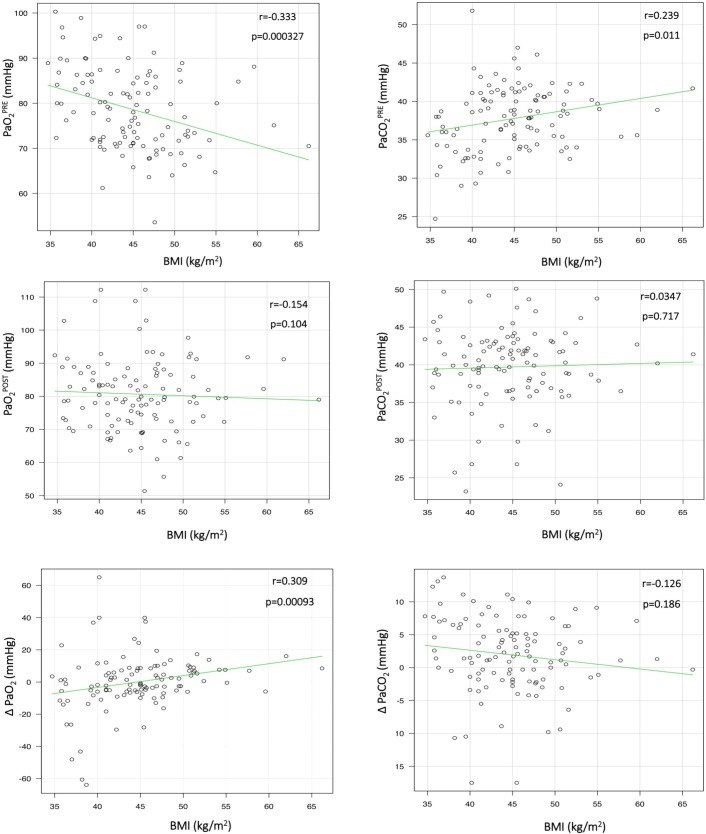
Correlation between body mass index and other variables.As shown, BMI was positively correlated with PaCO2PRE, PaCO2POST, and ΔPaO2 and negatively correlated with PaO2PRE, PaO2POST, and ΔPaCO2. BMI, body mass index; PaCO2POST, postoperative arterial partial pressure of carbon dioxide (PaCO2); PaCO2PRE, preoperative PaCO2; ΔPaCO2, PaCO2POST minus PaCO2PRE; PaO2POST, postoperative arterial partial pressure of oxygen (PaO2); PaO2PRE, preoperative PaO2; ΔPaO2, PaO2POST minus PaO2PRE; r, Bravais-Pearson correlation coefficient.